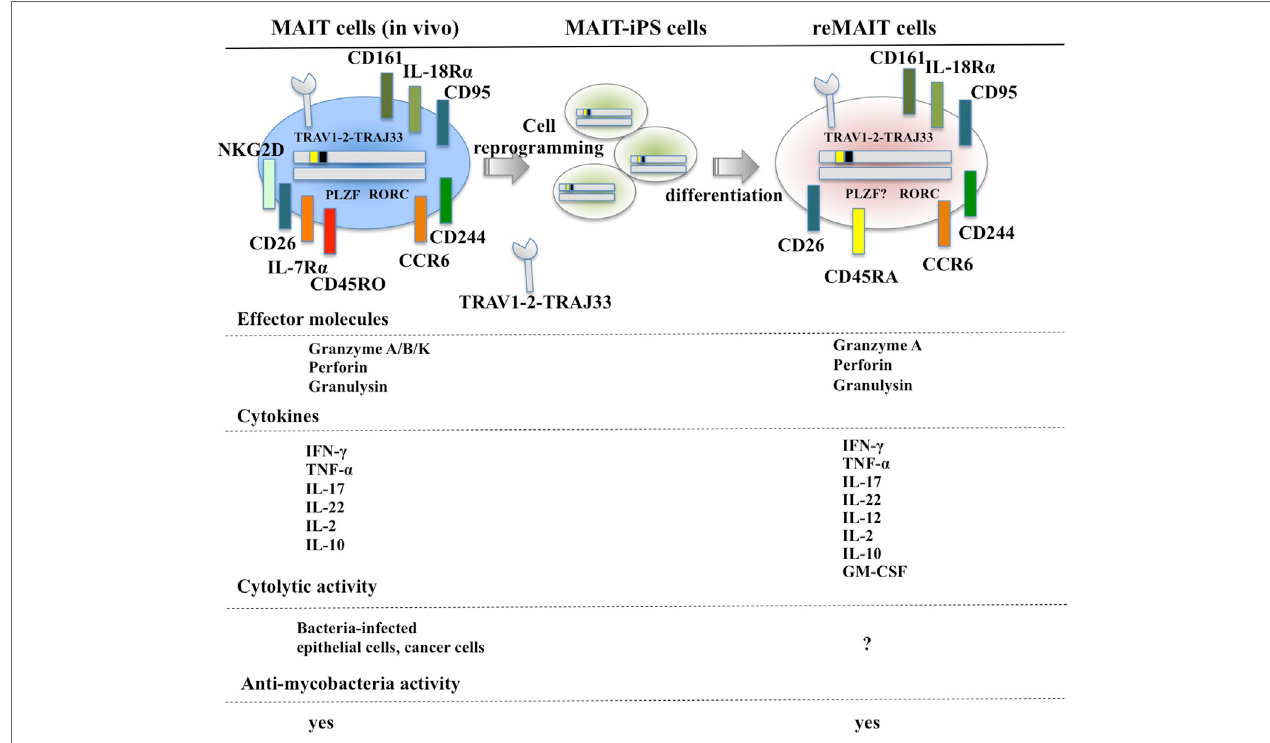
FiGURe 1 | Cell surface antigens, effector molecules, cytokines, and effector functions of MAIT and reMAIT cells. reMAIT cell differentiation from MAIT cell-derived iPS cells (MAIT-iPS cells) via cell reprogramming of MAIT cells is illustrated (upper panel). Representative antigens and effector molecules present in MAIT cells (left panel) and in reMAIT cells (right panel) are shown. The transcription factors rich in MAIT cells, such as promyelocytic leukemia zinc finger (PLZF) and related orphan receptor C (RORC), are also depicted, but the presence of PLZF in reMAIT cells has not been determined. Effector molecules and cytokines from MAIT and reMAIT cells are shown. In addition, the target cells for the cytolytic activity and antimycobacterial activity of MAIT cells and reMAIT cells are indicated. “?” indicates not